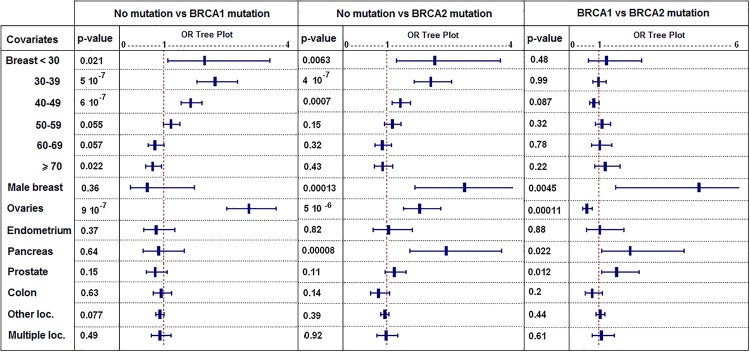
Cancer locations predicting the BRCA mutational risk.(logistic regression: p-values complete the information given by each Odds-Ratio; error bars represent 95%-CI of Odds-Ratios; covariates are cancer locations and "Breast < 30" means female breast cancers occurring before 30 years…).